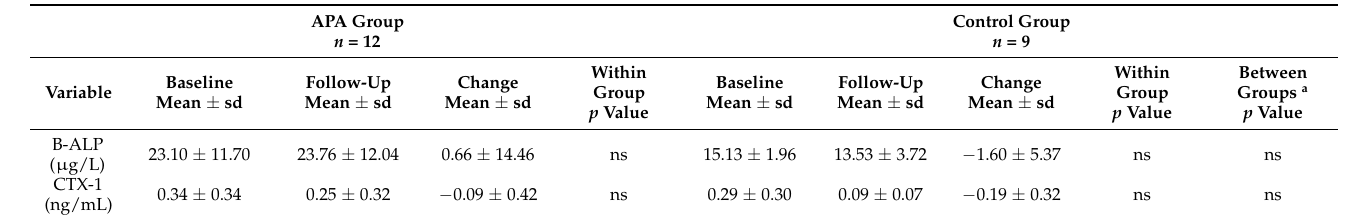
Table 2. Bone biomarker measured in the two study-groups at baseline, follow-up, and change at 6 months.